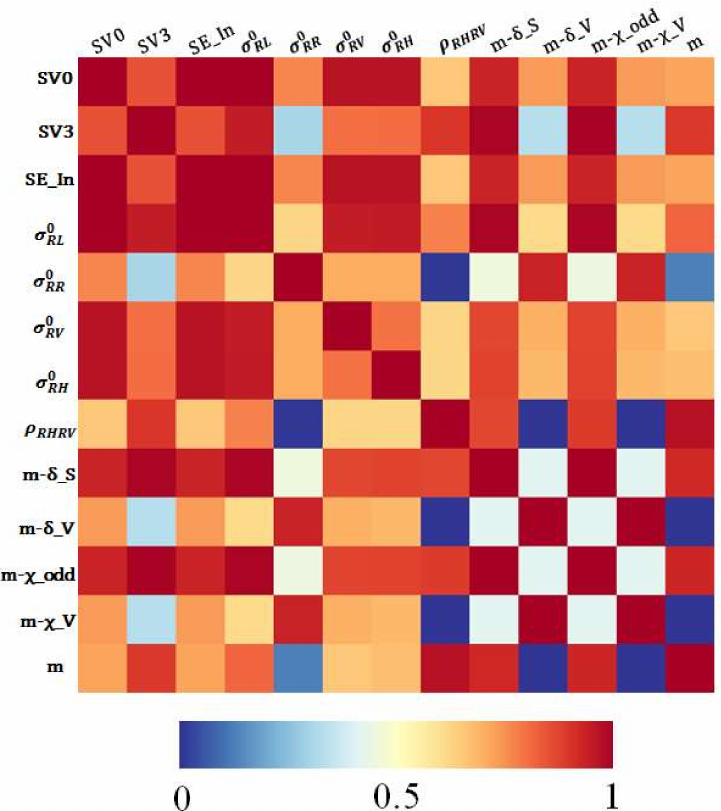
Figure 5. Absolute value of the Spearman correlation between the identified CP parameters with discrimination capability between FYI and MYI for the RCM HR